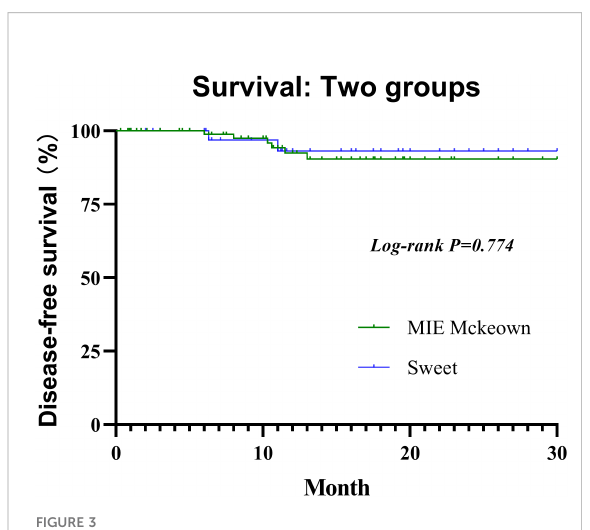
FIGURE 3 Kaplan – Meier estimates of DFS. DFS: Disease-free